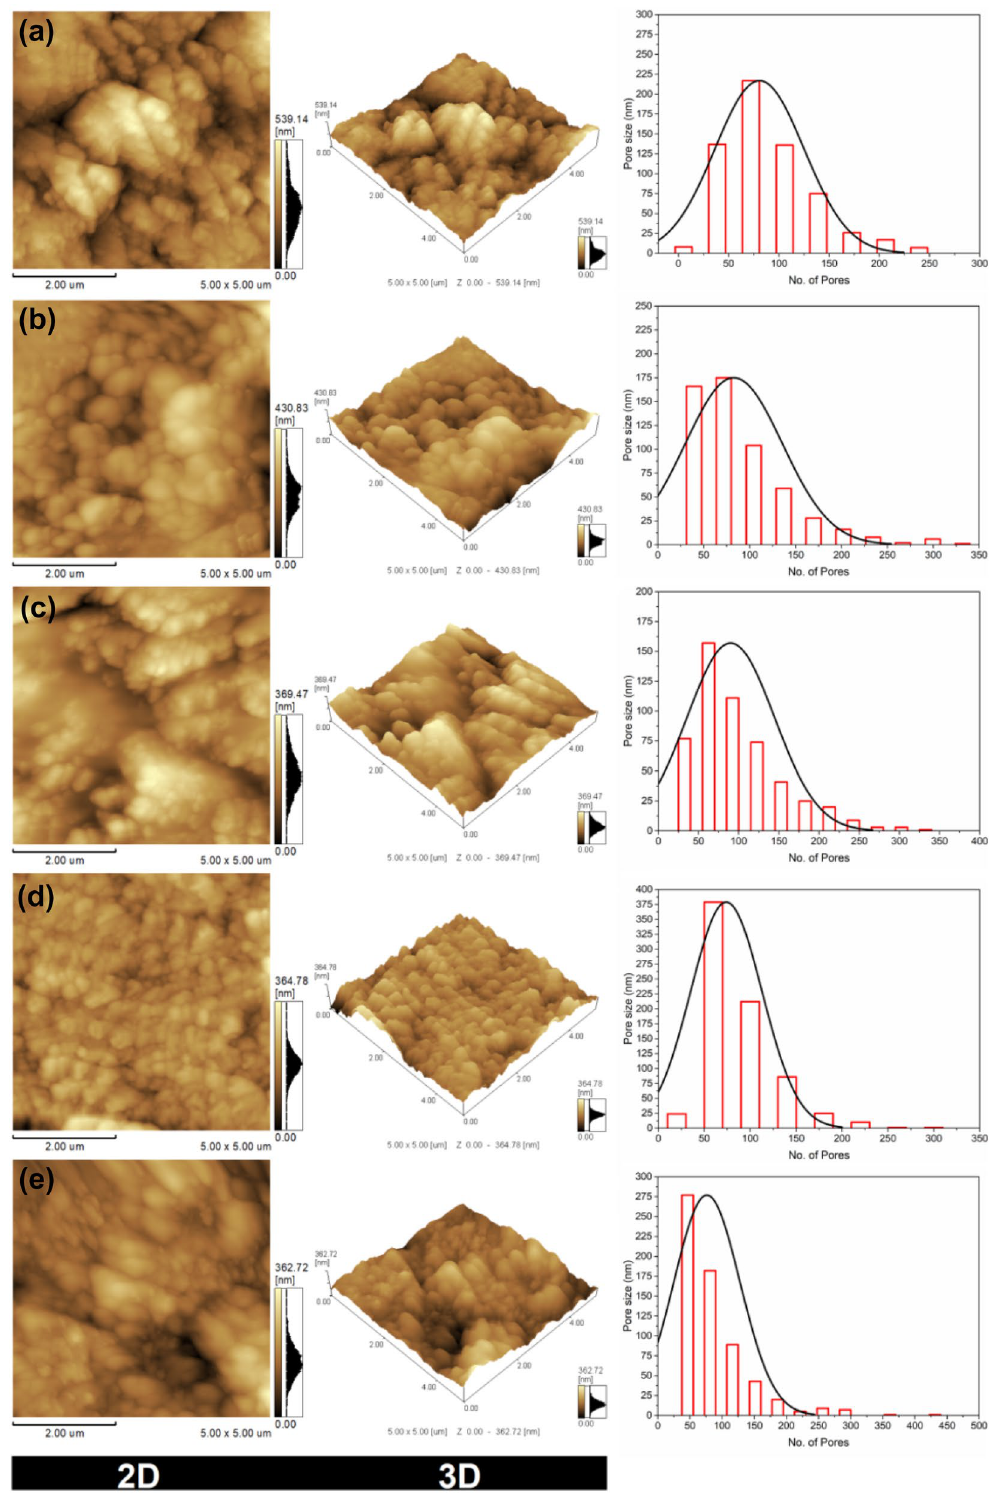
Figure 11. AFM 2 and 3 dimensional topography and pore size distribution of ( a ) TFC membrane, and ( b – e )